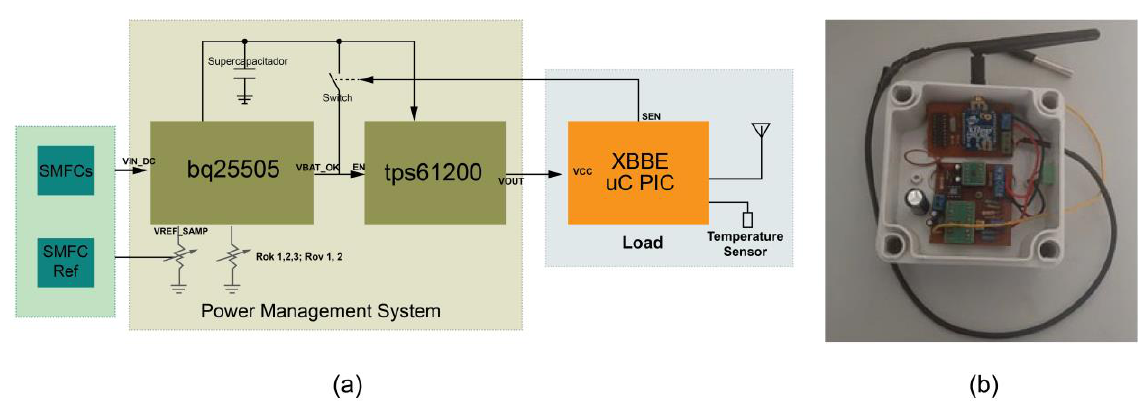
Figure 2. ( a ) Sensor node block diagram. ( b ) The implemented sensor node.